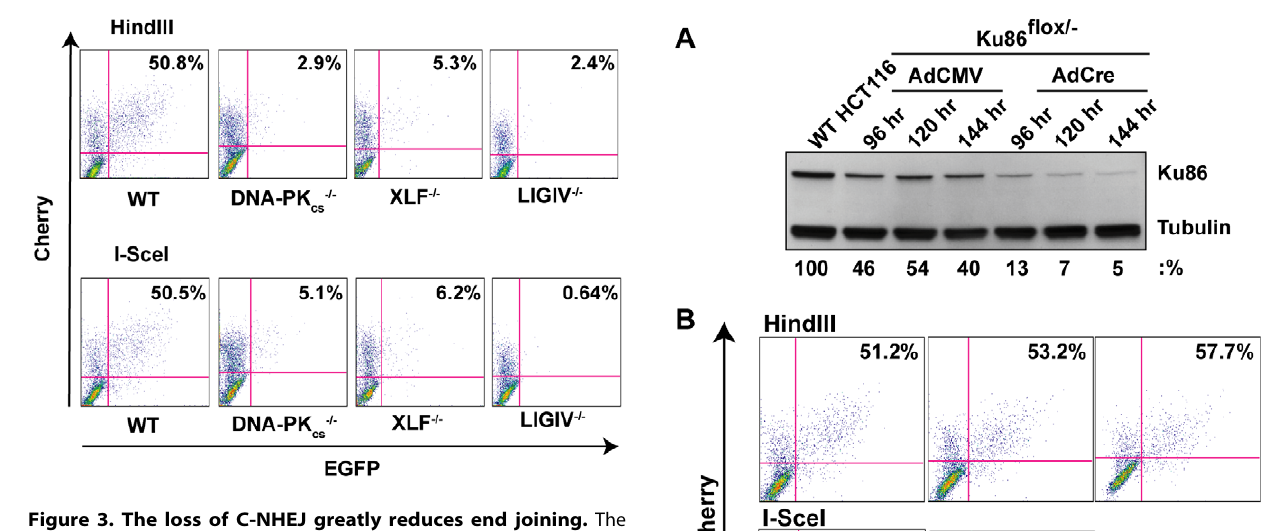
Figure 3. The loss of C-NHEJ greatly reduces end joining. The indicated cell lines were transfected with HindIII - (Top panels) or I -SceI - (Bottom panels) linearized pEGFP-Pem1-Ad2 plasmid together with a pCherry plasmid. The cells were analyzed by FACS 24 hr post transfection. The number of cells that were doubly EGFP (horizontal) and pCherry (vertical) positive versus the number that were pCherry positive was determined. For a given experiment the data are shown as percent repair in the upper right-hand corner of each plot.